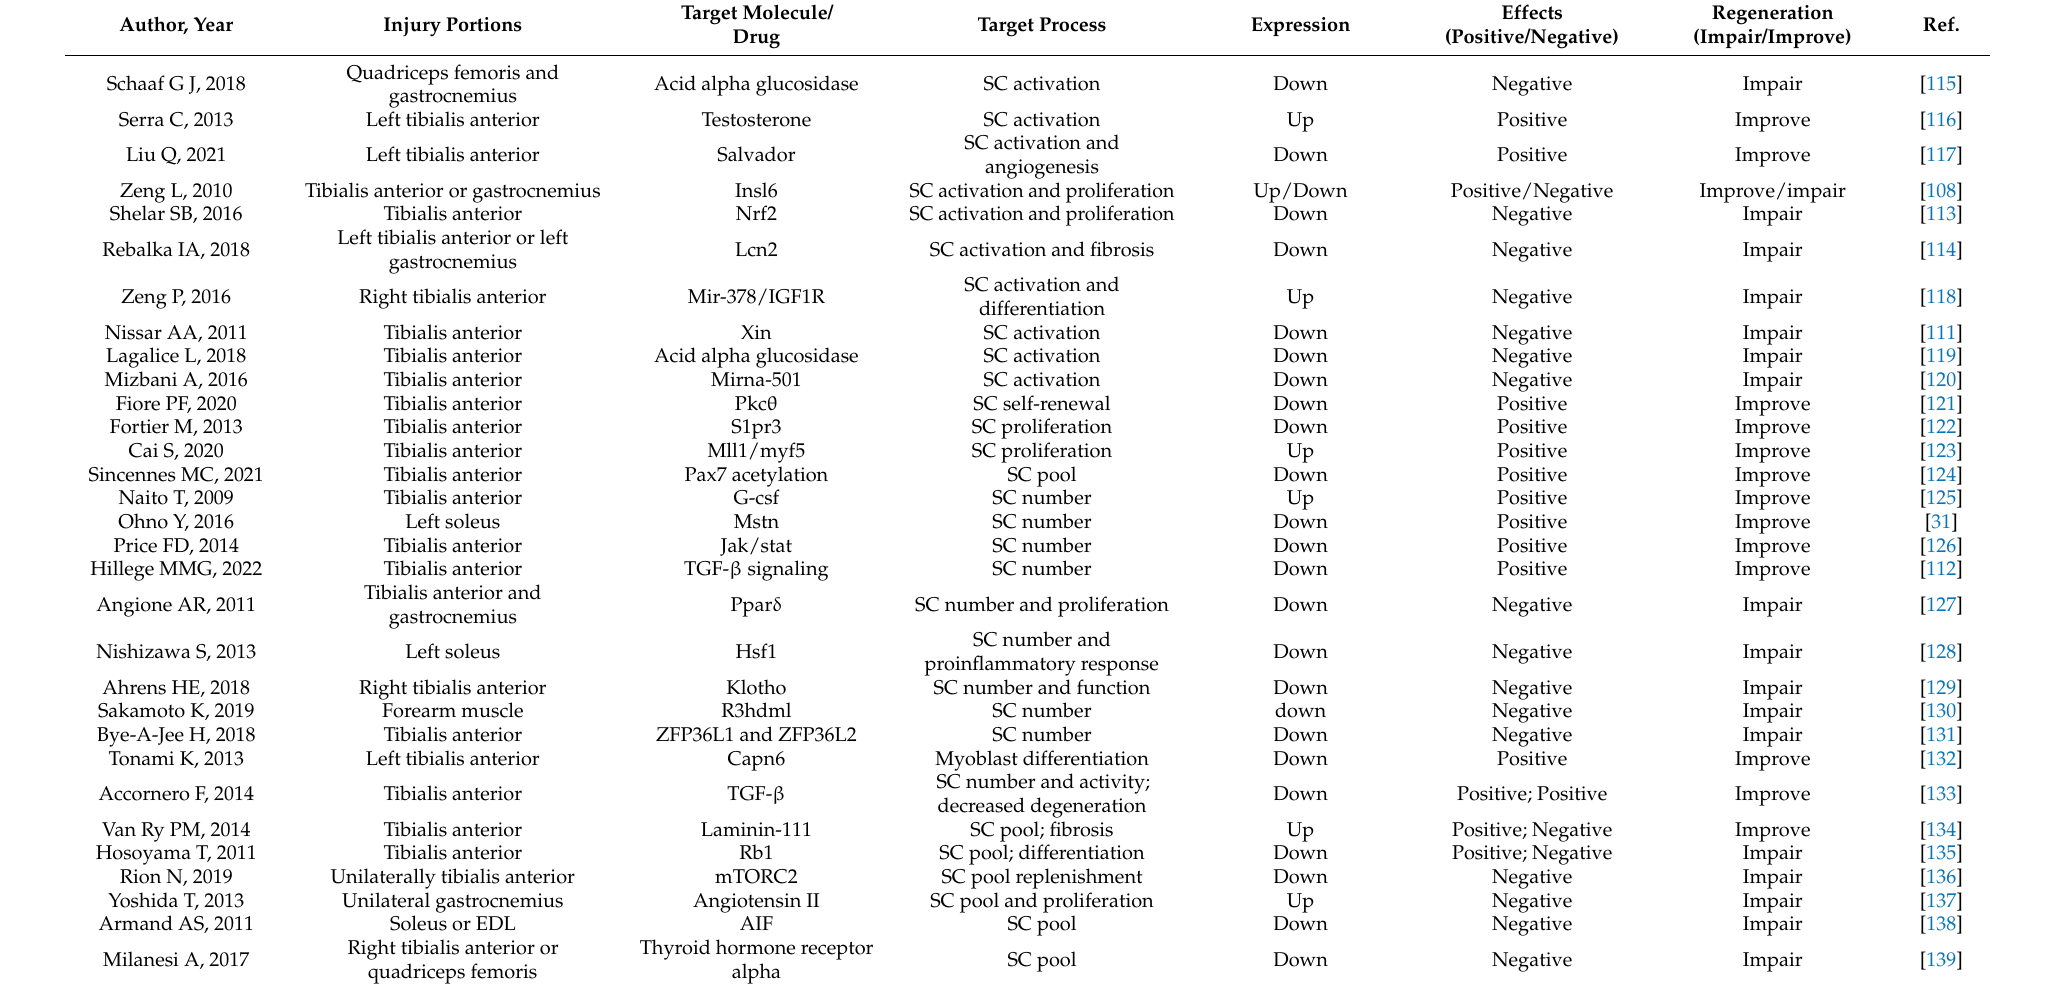
Table 3. The mechanism of SC activation, myoblast proliferation, differentiation, and